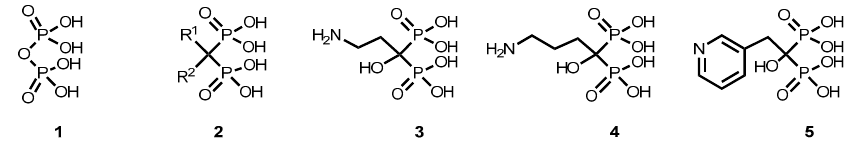
Figure 1. Chemical structures of pyrophosphoric acid, general formula of bisphosphonic acids and representative FDA-approved bisphosphonates clinically employed for the treatment of different bone disorders.